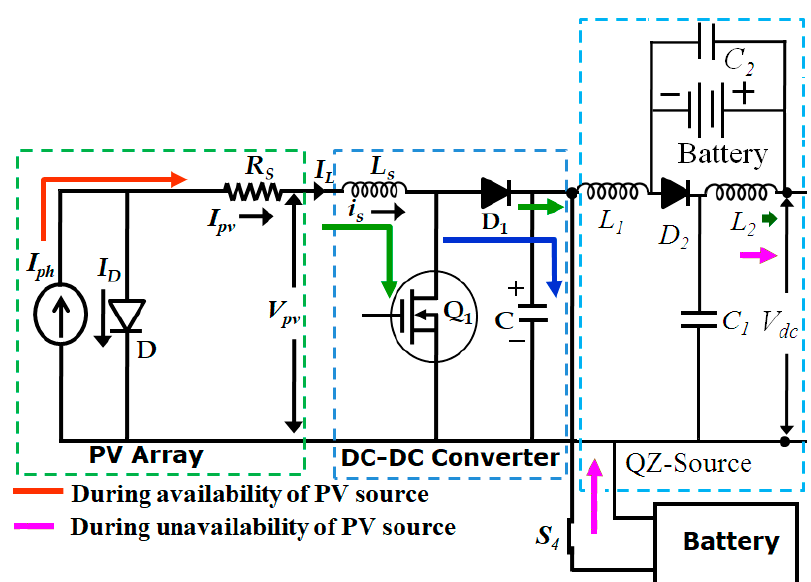
Figure 4. Current flow diagram for mode of continuous supply.